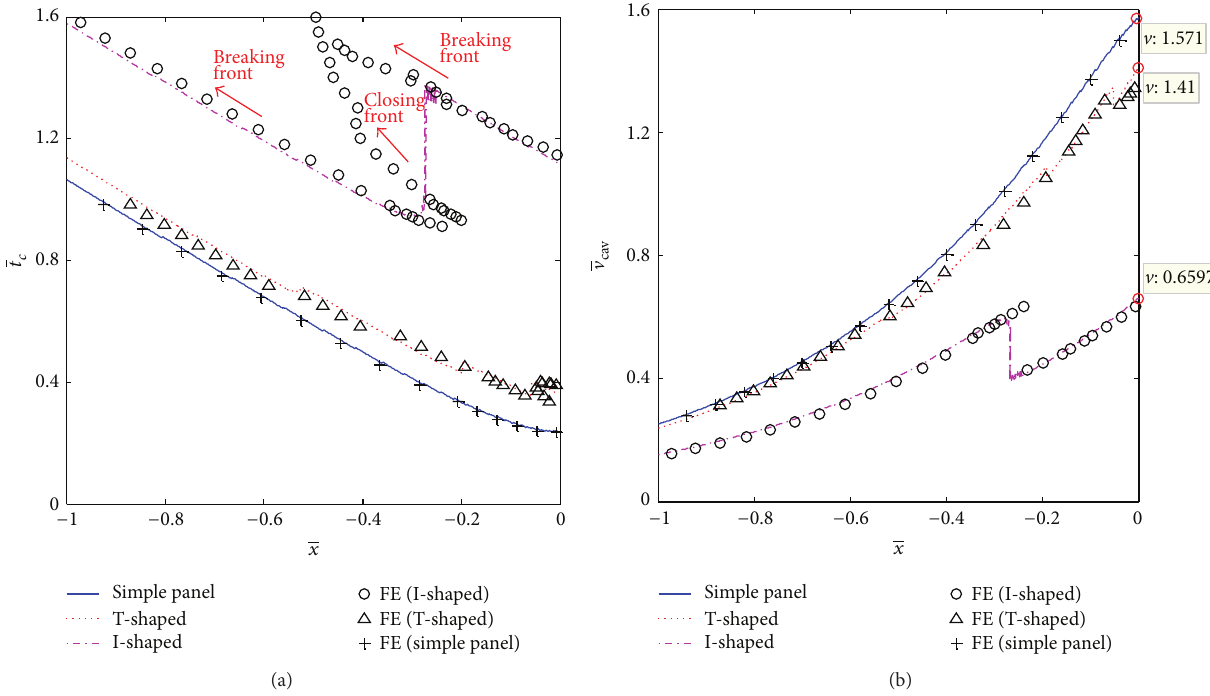
Figure 11: Analytical predictions and FE prediction of the spatial variation of (a) the time to cavitation and (b) the velocity V cav in the cavitated water at 𝑡 𝑐 (𝑥) . These results are for cases in Table 1, which are the simple panel, the panel with stiffener (T-shaped), and the panel with girder